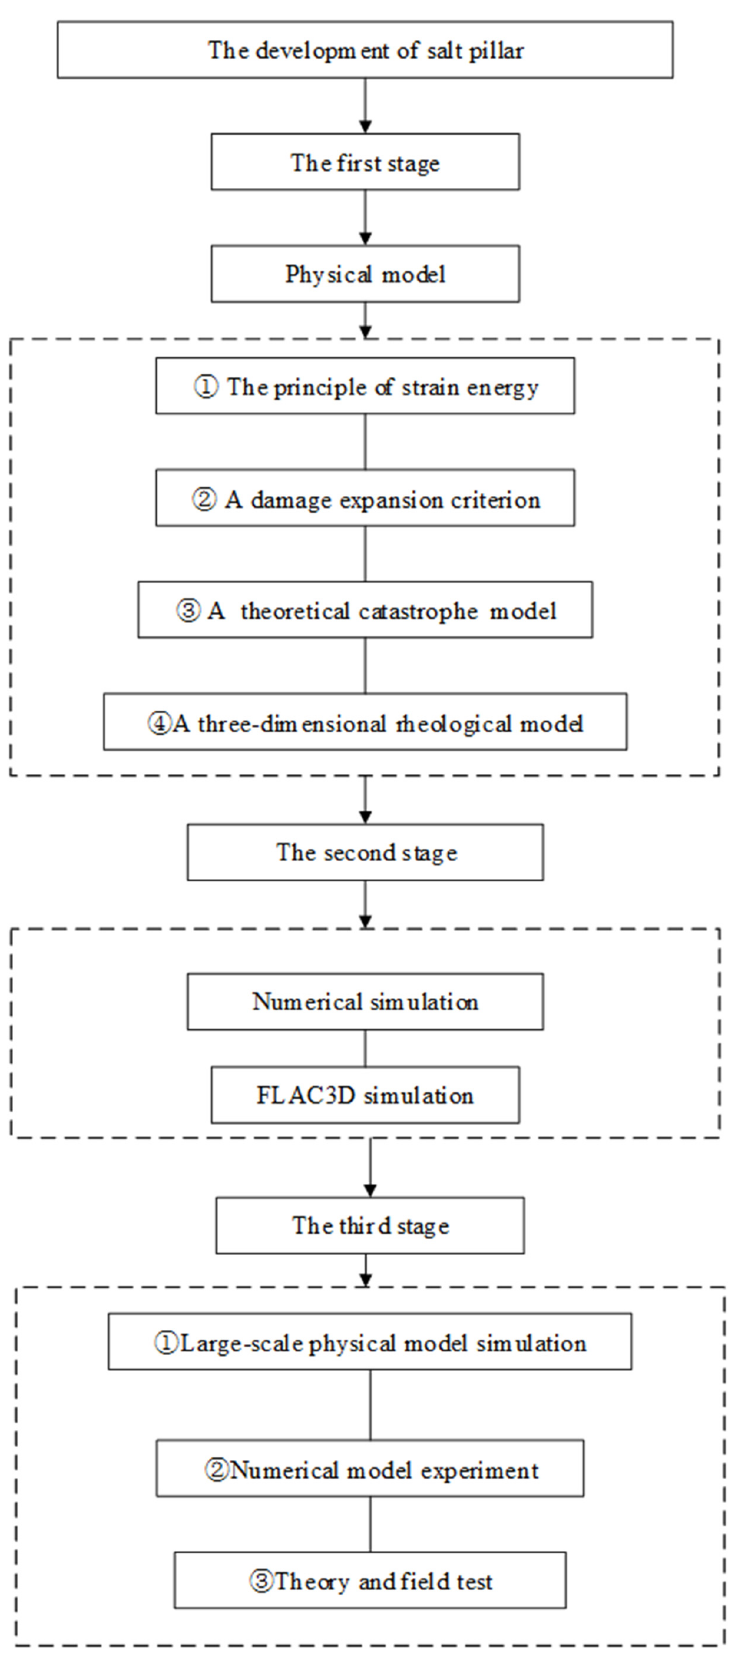
Figure 2. The current development of salt pillar design research.